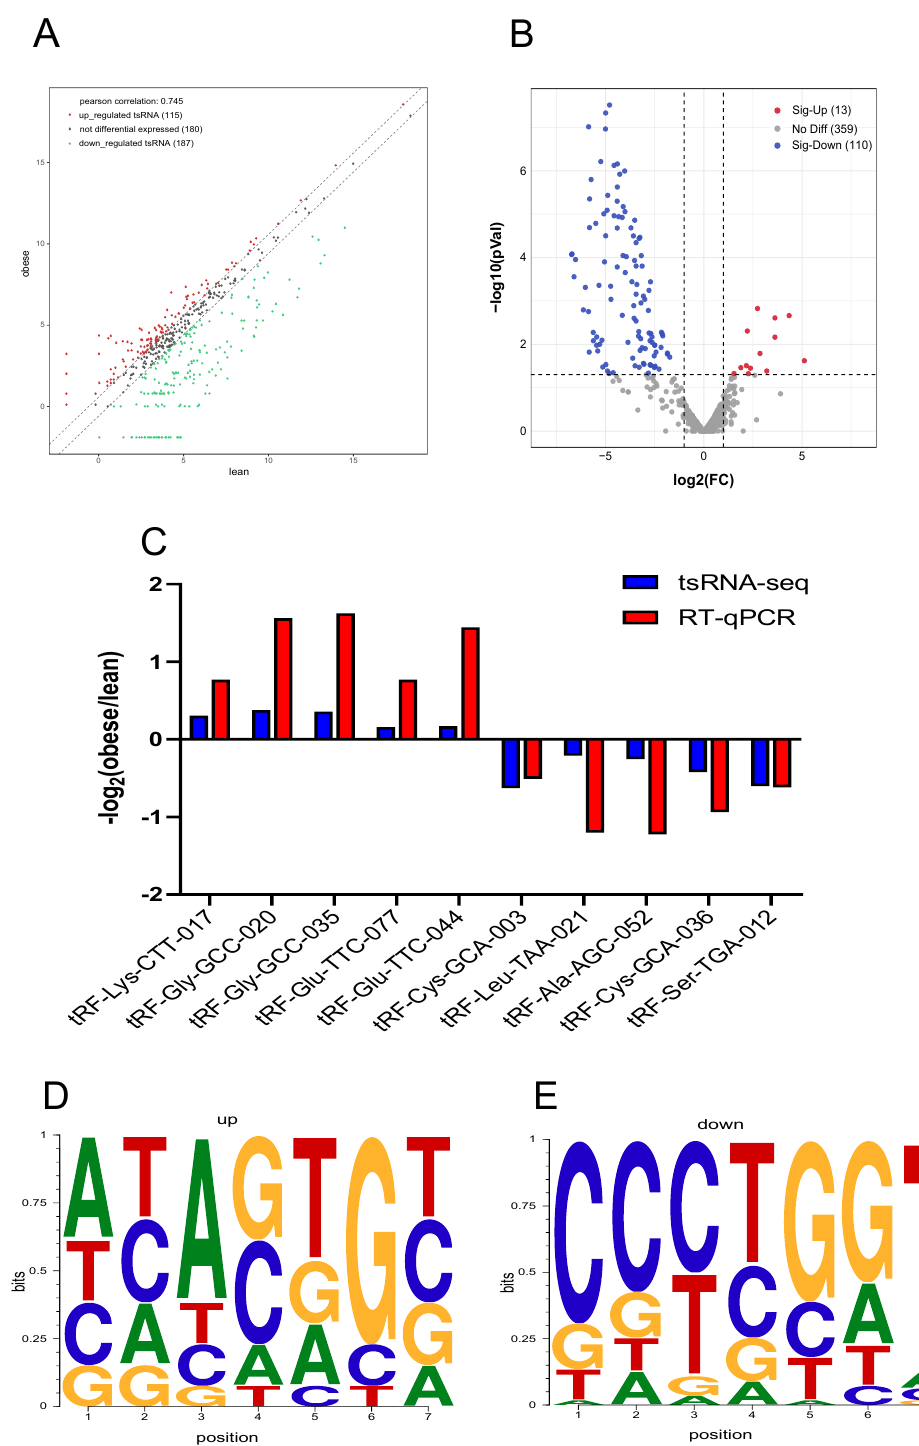
Figure 3. Analysis of differentially expressed tsRNAs. Scatter plot ( A ) and a volcano plot ( B ) of differentially expressed tsRNA, red dots represent increased tsRNA in obese pigs compared with lean pigs, blue dots represent decreased tsRNA in obese pigs compared with lean pigs. ( C ) RT-qPCR verified tsRNA sequencing results ( n = 6). ( D , E ) Bias of differentially expressed tsRNA seed